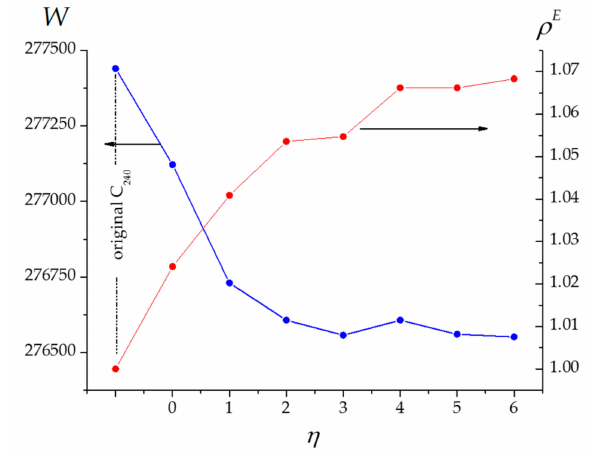
Figure 6. Changes in the Wiener index ( W ) and extreme topological roundness ( ρ E ) upon the dislocation dipole propagation over the C 240 surface, from the original I h fullerene to η =